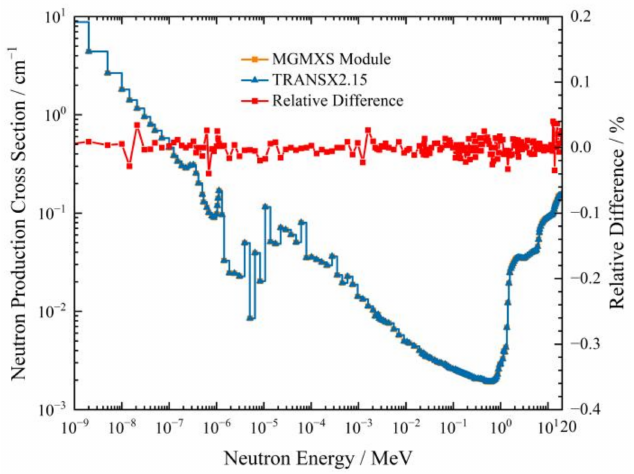
Figure 4. The relative differences of neutron production